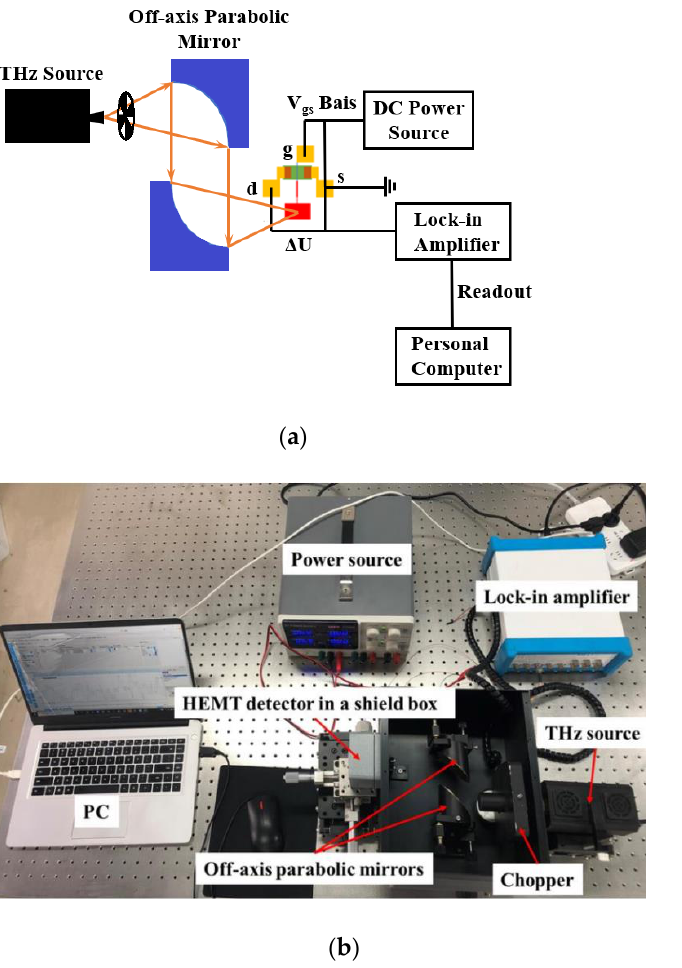
Figure 7. The platform for the characterization of the detector: ( a ) the diagram; ( b ) the practical picture.